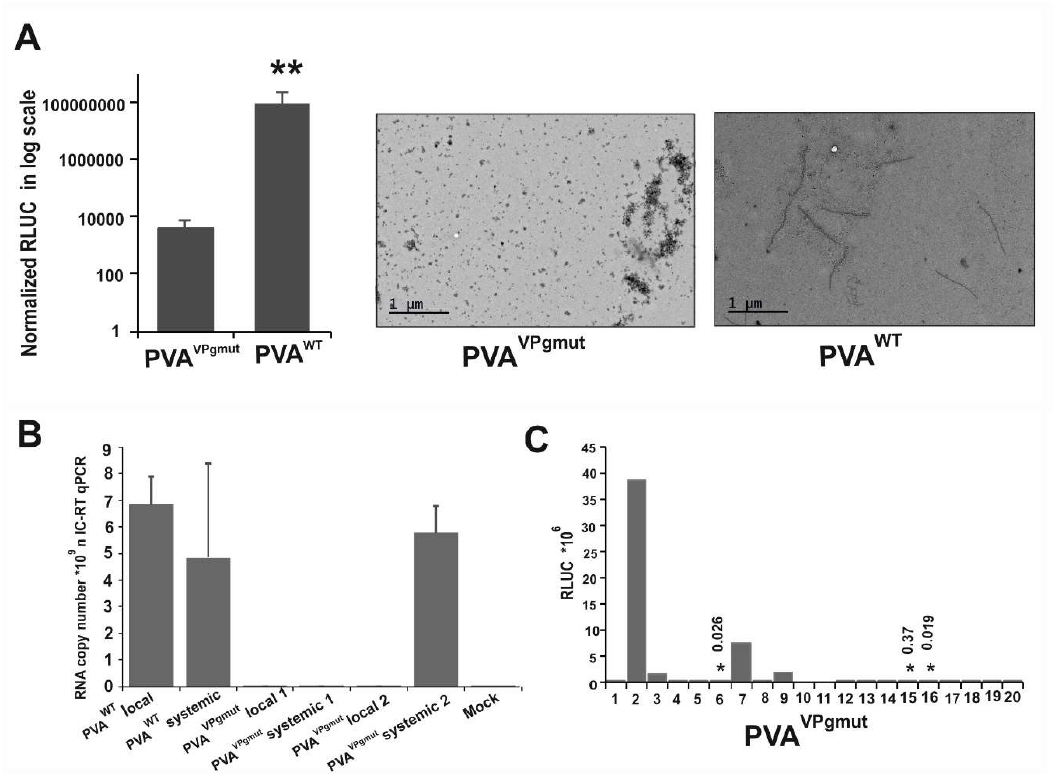
Figure 3. PVA VPgmut genome reverts to PVA WT . PVA WT and PVA VPgmut cDNAs were Agrobacterium- infiltrated into N. benthamiana leaves at an OD 600 of 0.05. In ( A ) the samples were collected at 7 dpi followed by a RLUC assay to determine virus-derived 3’RLUC activity (left panel; ( n = 6)). A Student’s t -test showed the significance of the difference between PVA VPgmut and PVA WT ; p -value < 0.01 is indicated with **. Particle formation in the infiltrated leaves at 7 dpi was investigated by electron microscopy. No particles were detected in PVA VPgmut -containing leaves. ( B ) The accumulation of CP-associated viral RNA was quantitated in the local and systemic leaves of N. benthamiana 10 dpi by IC-qRT-PCR. RNA copy numbers in the local and systemic leaves of PVA VPgmut -infiltrated plants were determined from two individual plants (indicated as 1 and 2). ( C ) 3’RLUC expression in the systemically-infected N. benthamiana leaves following the reversion of PVA VPgmut to PVA WT . As verified by sequencing, reversion occurred in this experiment in seven out of 20 plants. The 3’RLUC values that are too low to see as a distinguishable column are marked by asterisks, and the corresponding 3’RLUC value is given.